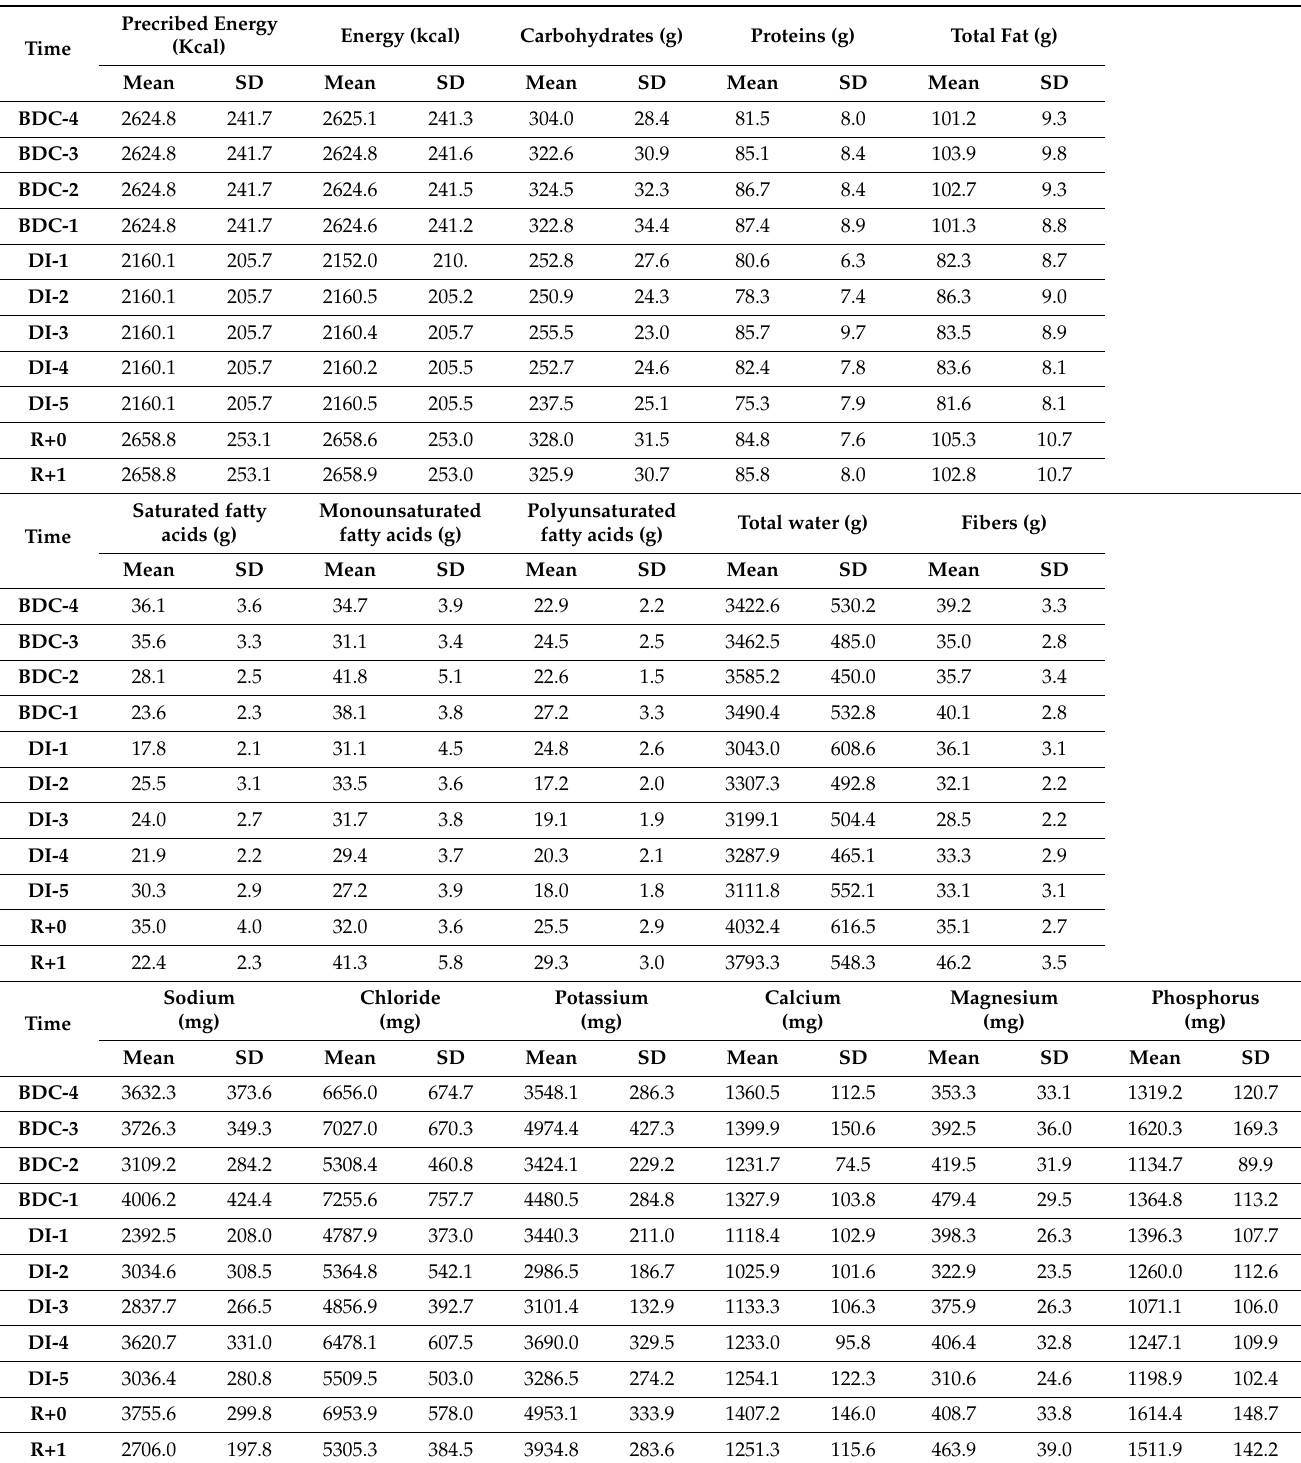
Table 3. Daily Nutrient